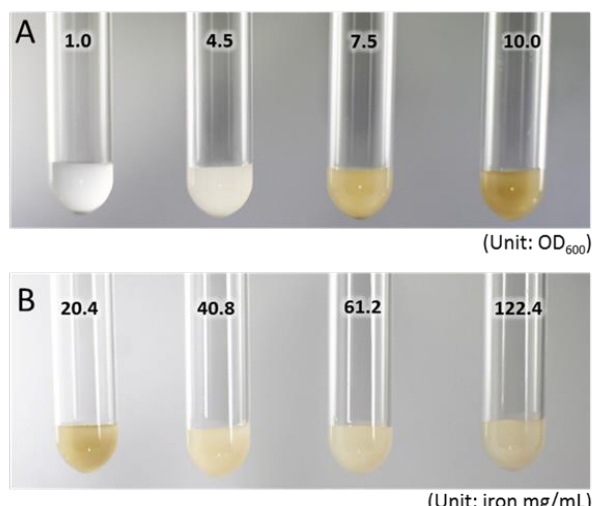
Figure 2. Pigment changes in M. sporium 5 cultured in NMS media during sMMO expression. ( A ) Normal media show color changes by increasing optical density at 600 nm (OD 600 , presented as numbers). The white pigment around OD 600 of 1.0 changed to pink–orange around 3.0, and media changed to brown–black at OD 600 values over 8.0. These changes were only observed in M. sporium 5 among other Methylosinus . ( B ) All cells were cultured to an OD 600 of 8.5 in media with different iron concentrations. Normal NMS media for growing M. sporium 5 contained 20.4 mg/mL (1 × ) of iron and showed a dark brown color. Iron-supplemented NMS media (40.8, 61.2, and 122.4 mg/mL of iron in media) did not show color changes upon increasing optical density.